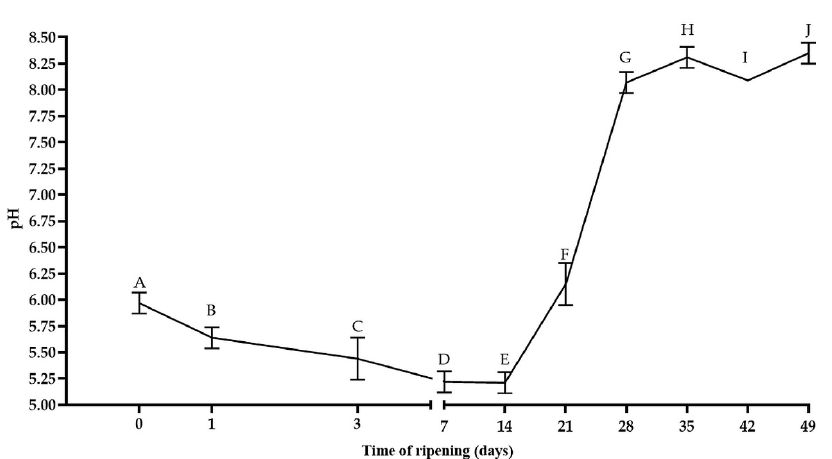
Figure 3. Changes in pH during the ripening time. Means with different letters (A–J) are significantly different at p < 0.05.